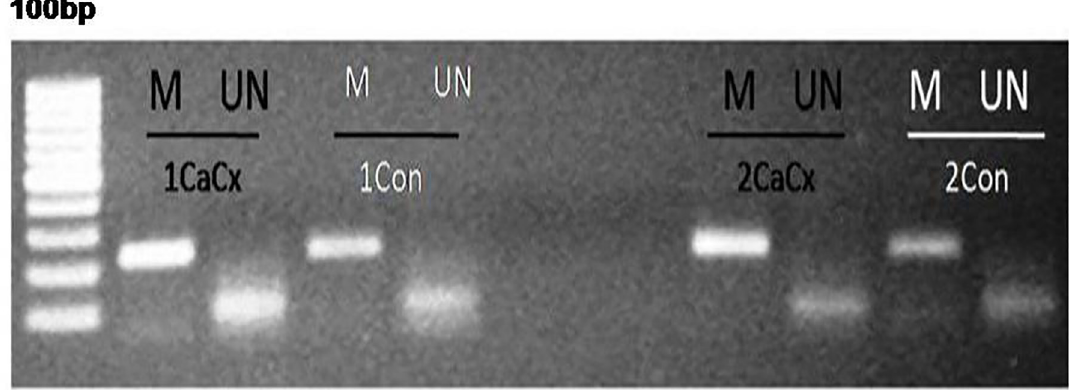
Fig 5. Representative agarose gel electrophoresis photograph showing p53 methylation profile analysis by MSP methods in Cacx (cervical cancer) and Con (non neoplastic control) cases; M represents methylated and UN represents unmethylated based assay.